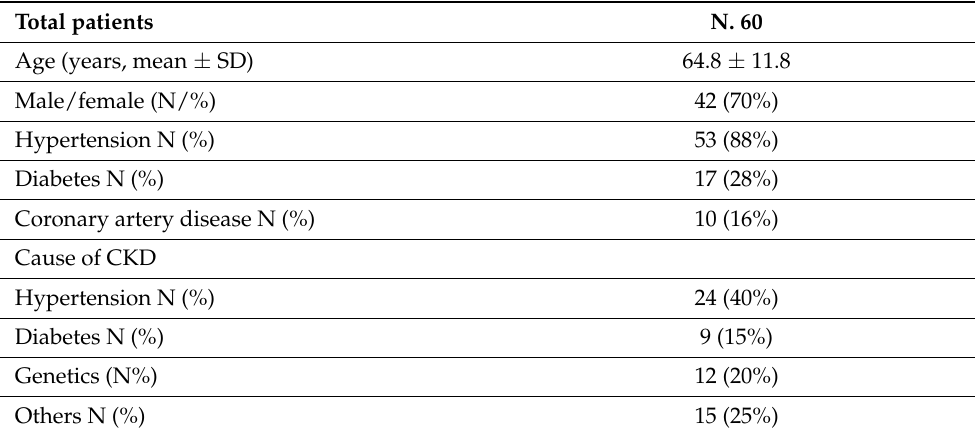
Table 1. Characteristics of the enrolled subjects.